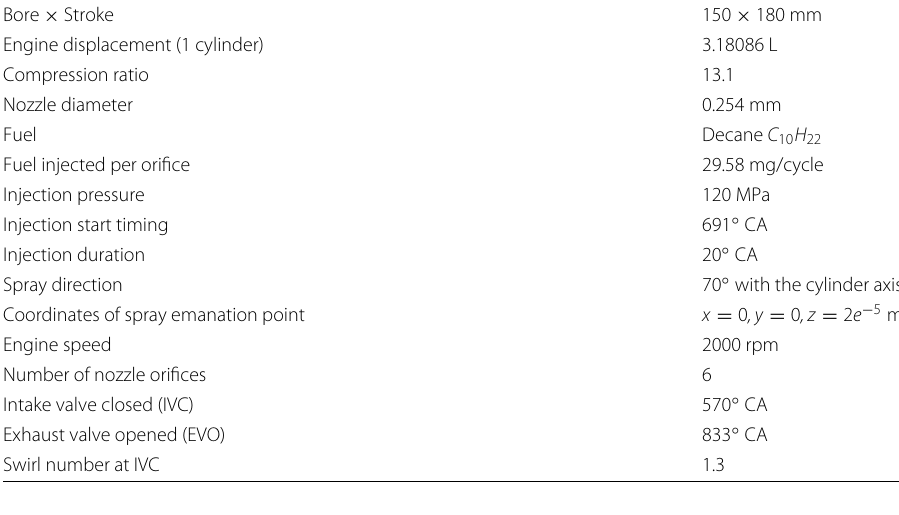
Table 1 Engine specifications and operational conditions